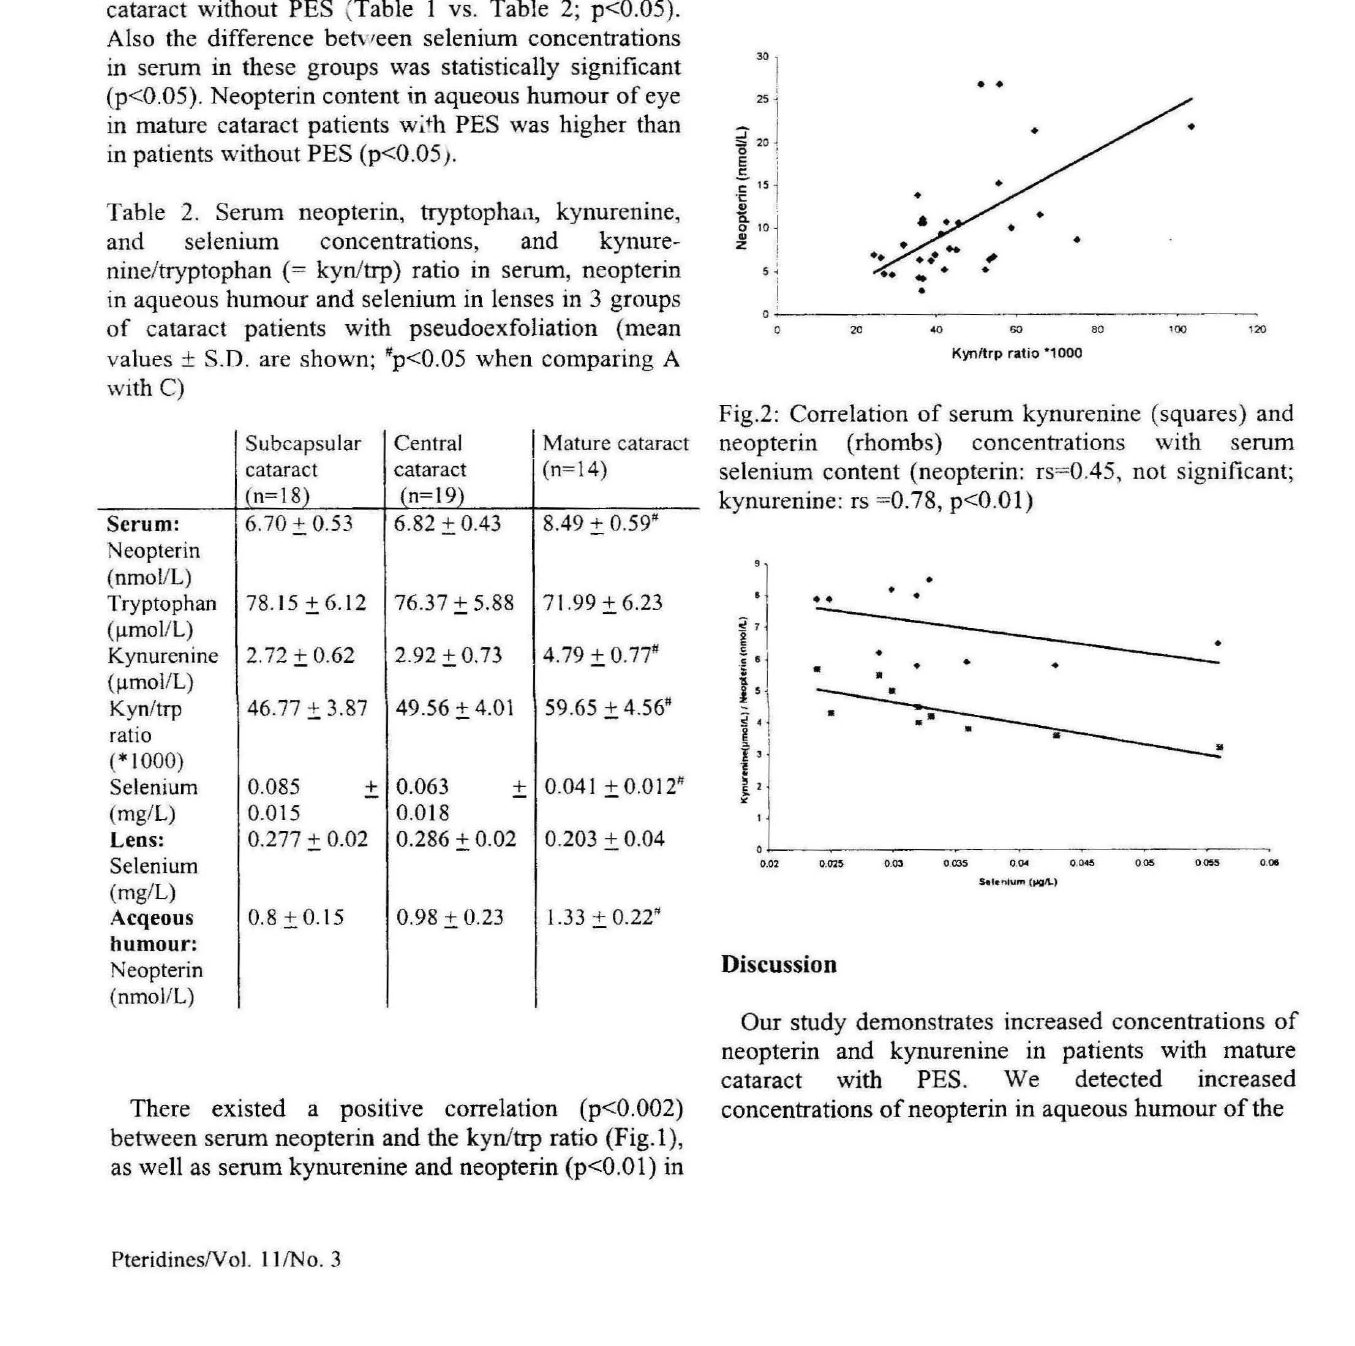
Fig.l: Correlation between serum neopterin and the kynurenine/tryptophan (kyn trp) ratio * 1000 in cataract patients with pseudoexfoliation (rs=0.59; p<O.002)